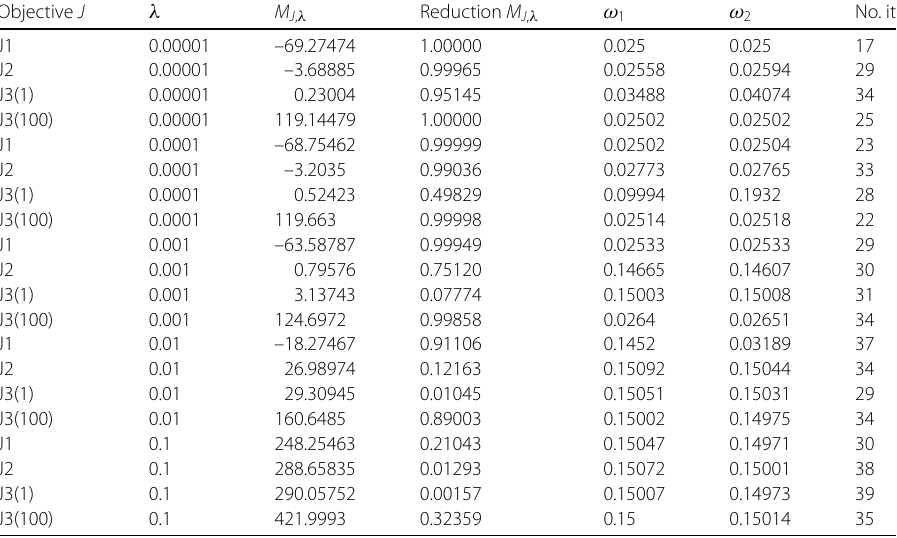
Table 5 Optimization of gas flow rates. Minimum objectives M J , λ and corresponding frequencies ω i , i ∈ { 1,2 } . The last column is the number of required optimization iterations. (cid:18) t = 0.025, mesh 3 Objective